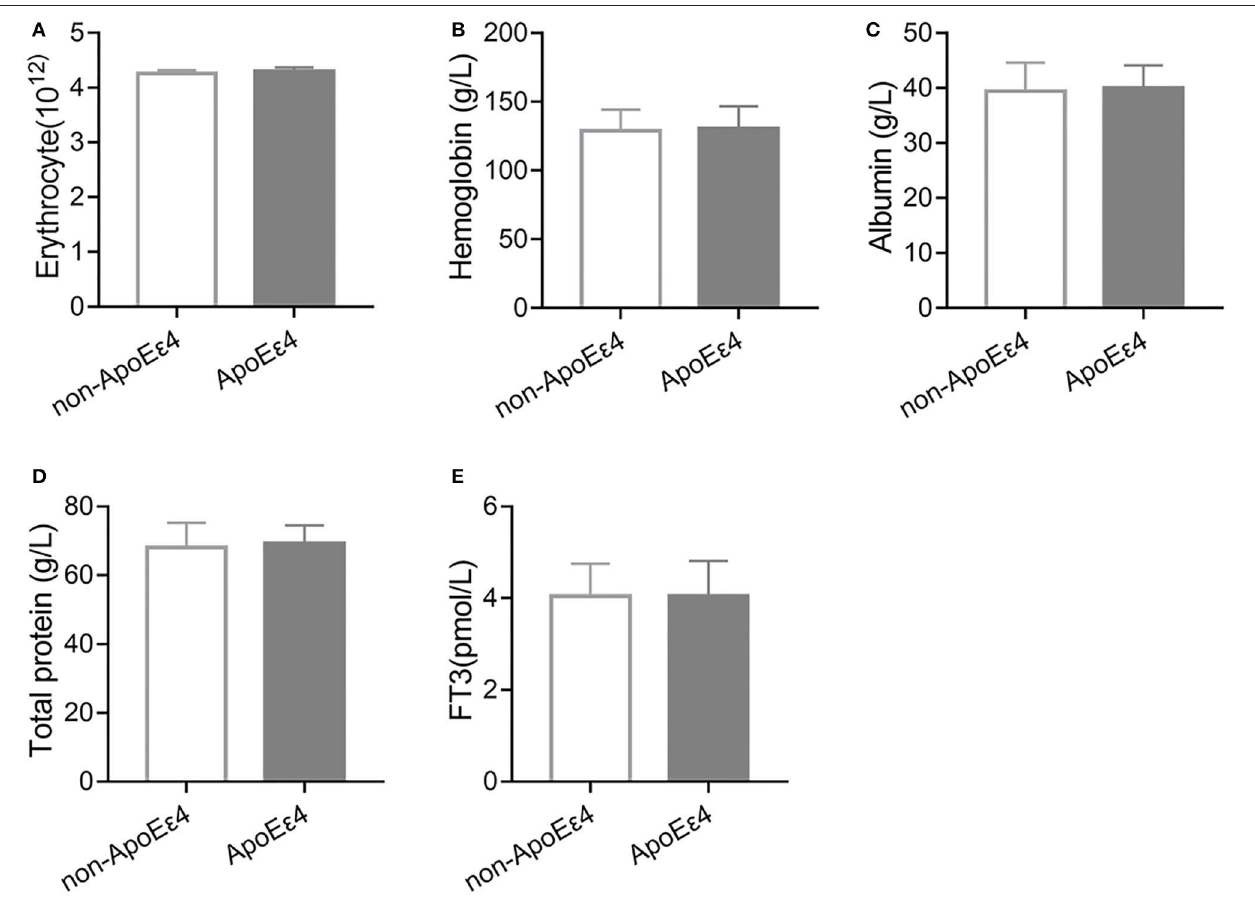
FIGURE 1 | Malnutrition indicators and FT3 levels were independent of ApoE genotype. (A) There was no significant change in erythrocyte number between non-ApoE ε 4 ( n = 91) and ApoE ε 4 ( n = 81, P > 0.05) carriers. (B) Hemoglobin level was similar between non-ApoE ε 4 ( n = 96) and ApoE ε 4 ( n = 90, P > 0.05) carriers. (C) There was no significant difference in albumin levels between non-ApoE ε 4 ( n = 80) and ApoE ε 4 ( n = 75, P > 0.05) carriers. (D) There was no significant difference in total protein levels between non-ApoE ε 4 ( n = 79) and ApoE ε 4 ( n = 74, P > 0.05) carriers. (E) There was no significant difference in FT3 levels between non-ApoE ε 4 ( n = 95) and ApoE ε 4 ( n = 90, P > 0.05)